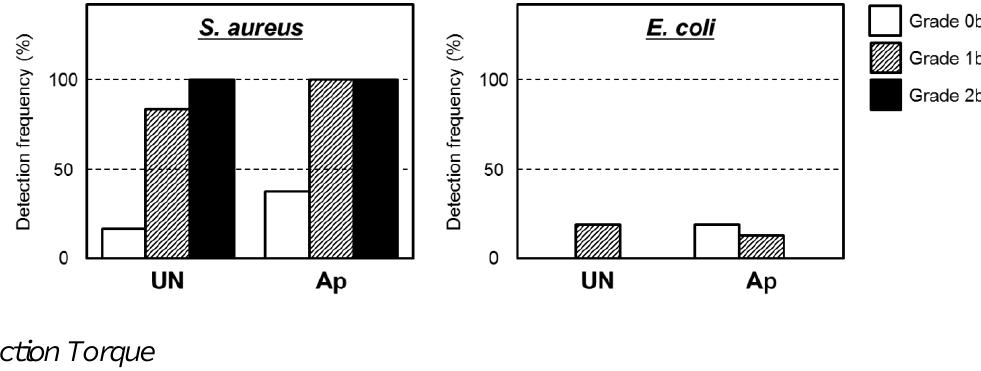
Figure 9. Detection rates of S. aureus and E. coli in bone tissue, by inflammation